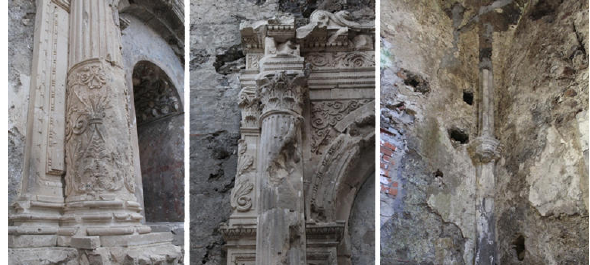
Figure 5. View of the decorative elements of the altars